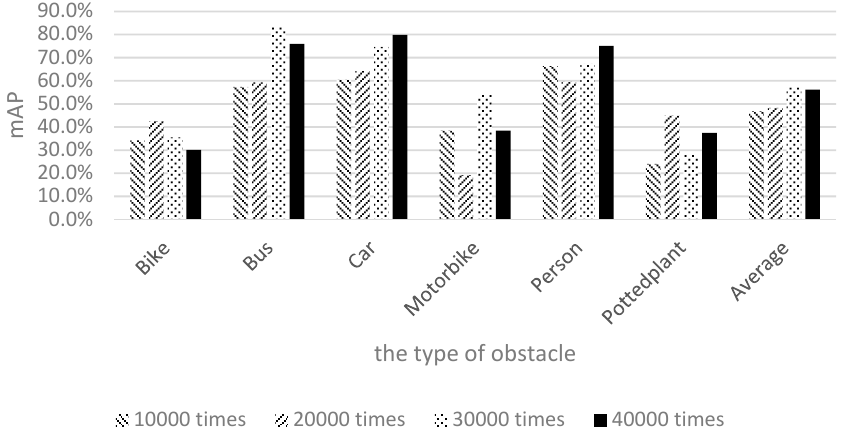
Figure 15. Results of using only Pascal images for training.